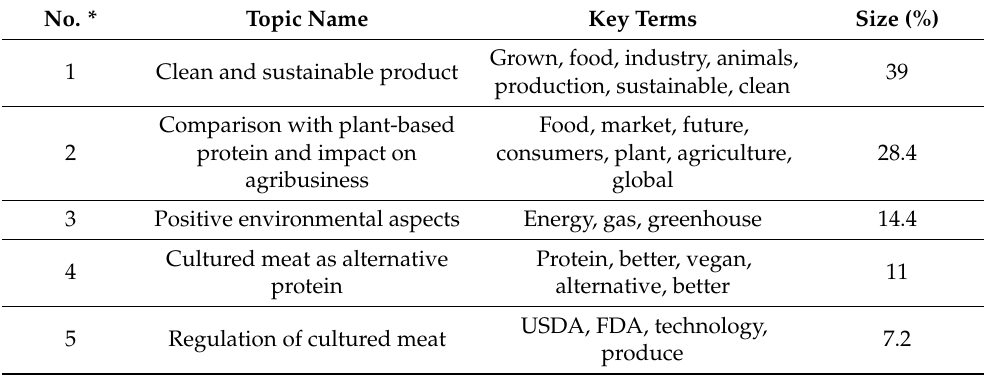
Table 4. Topics extracted based on LDA